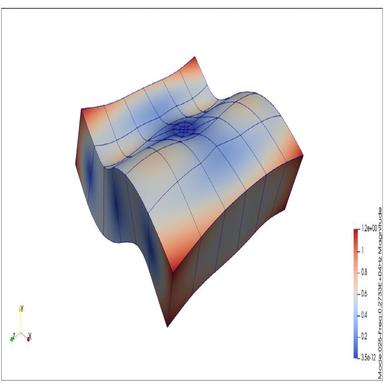
CUF model: 25th mode shape of the unit cell (Melamine+Aluminium).